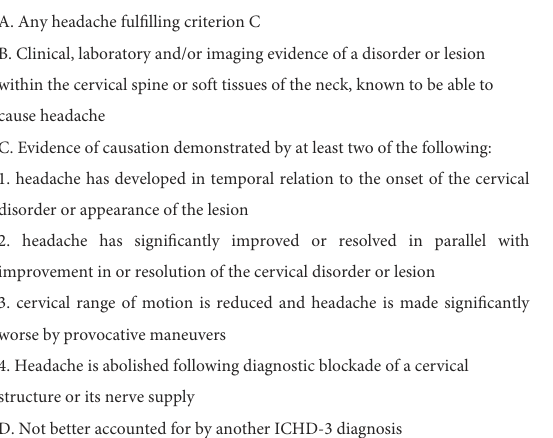
TABLE 2 Comparison of participant characteristics of the 2 treatment groups at